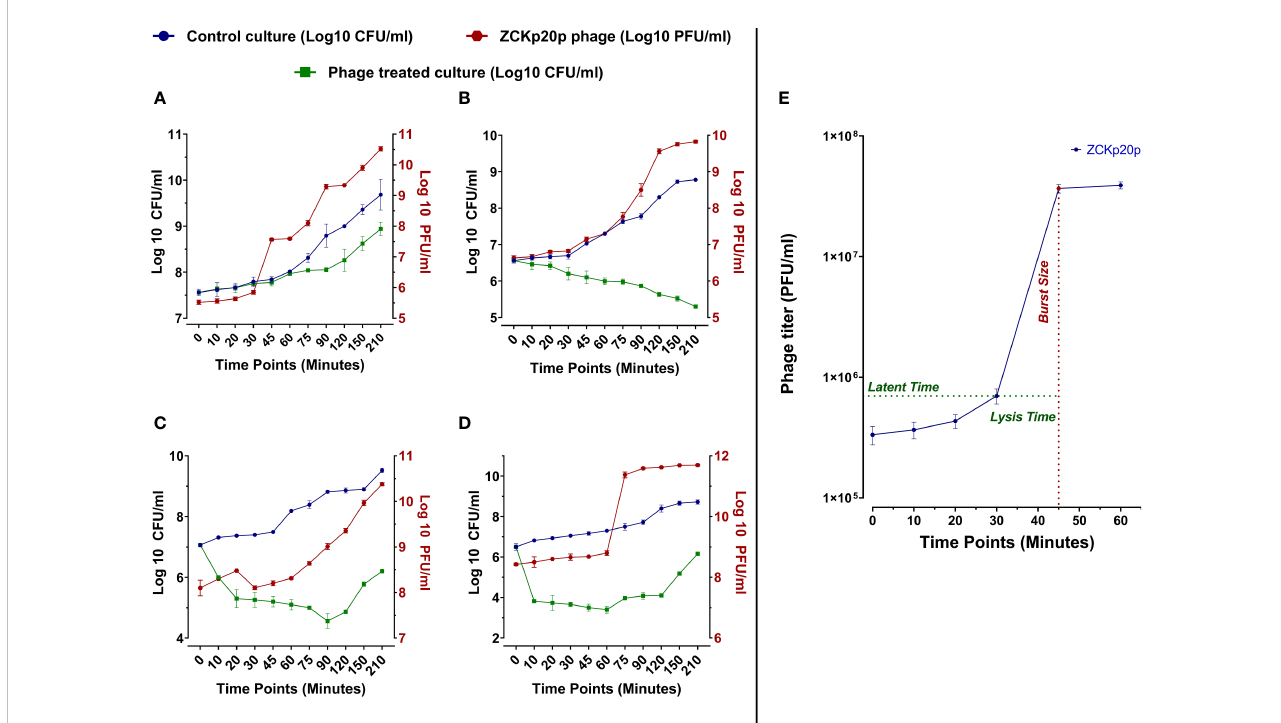
FIGURE 4 In vitro bacteriolytic dynamics of phage vB_Kpn_ZCKp20p at different MOIs (0.1, 1, 10, and 100) and one-step growth curve. MOIs are separately represented in the above charts ( A – D , respectively). Blue and green lines are plotted against the left Y-axis, representing the mean bacterial count of the control culture (untreated) and the survived bacteria of phage treated culture, respectively. The red line represents the mean of phage titers determined by spot test (Carlson, 2005). The mean of phage titers is plotted against the right Y-axis. The results were plotted as the mean of triplicates with error bars of ± SD. (E) One-step growth curve of phage vB_Kpn_ZCKp20p at MOI 0.1. Results are mean values ± SD of phage titer (PFU/ml). The phage titer (blue line) was determined at an interval of 10 to 15 min post-infection, and titers were determined by spot test (Carlson, 2005) — the latent period of about 30 min and the lysis time ( ∼ 15 min) during which the bacterial cells start to burst till they reach a maximum and form a plateau of released PFU. The burst size (red) was estimated at 100 PFU/cell ( ±